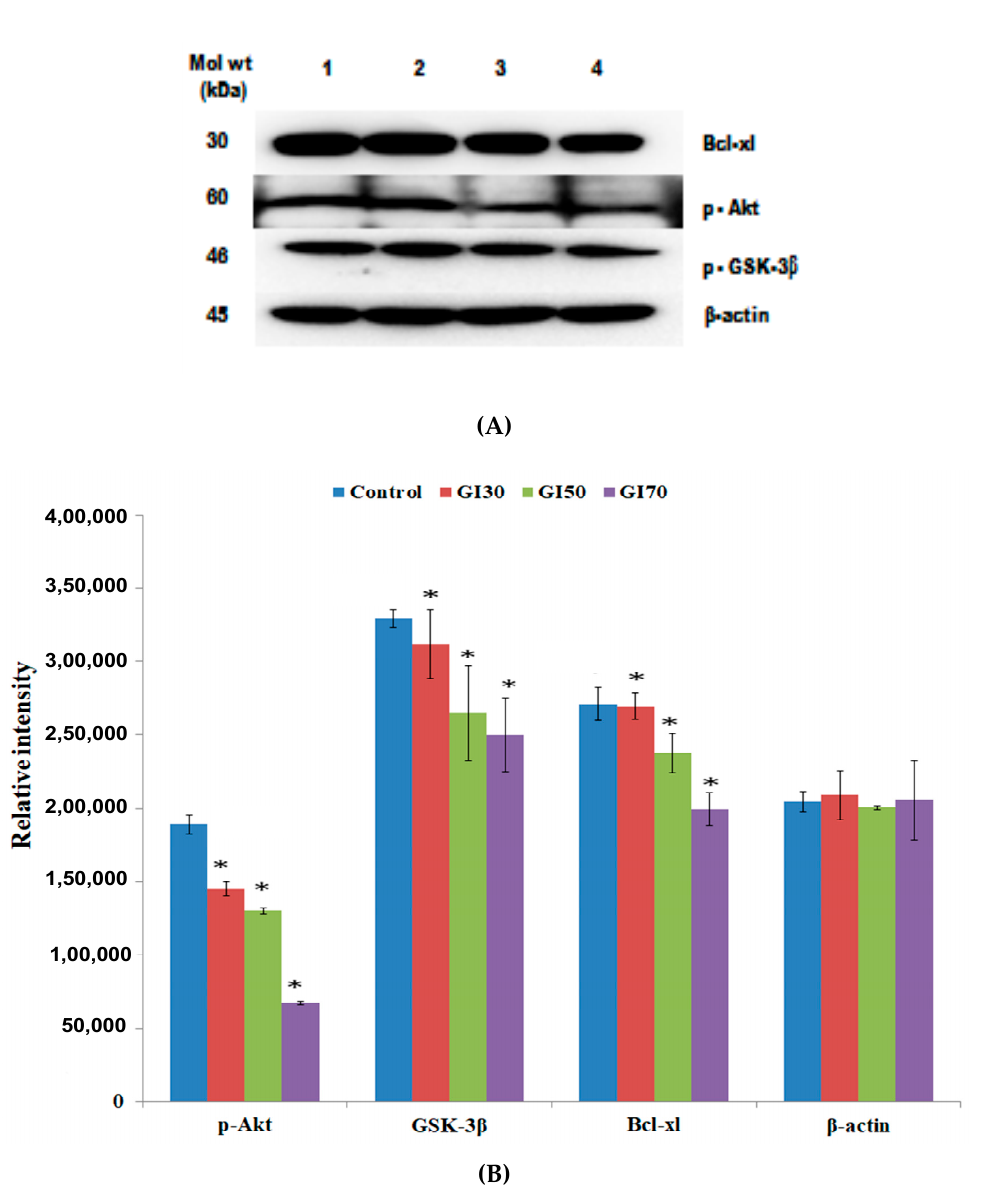
Figure 16. ( A ) Effect of Epiafzelechin from C. fistula on the expression level of p-Akt (Protein kinase B), p-GSK-3 β (Glycogen synthase kinase-3 beta), and Bcl-xl (B-cell lymphoma-extra large) proteins in MG-63 cells as detected using Western blotting. Band density was measured and normalized to that of β -actin. (Lane 1: control; Lane 2: GI-30 of Epiafzelechin; Lane 3: GI-50 of Epiafzelechin; Lane 4: GI-70 of Epiafzelechin). ( B ) Histograms showing densitometric analysis of Bcl-xl, p-Akt and p-GSK-3 β proteins bands in western blotting in Epiafzelechin treated and control cells. Values are expressed as mean ± SE. * indicates statistically a significant difference at ( p ≤ 0.05).